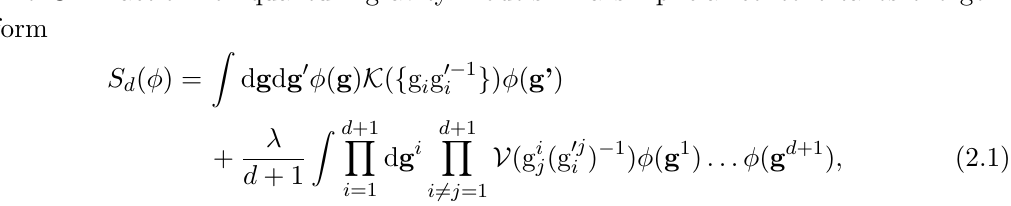
Figure 1 . Excitation of the field φ ( g simplicial representation as a tetrahedron; on the right, the dual representation as a spin network